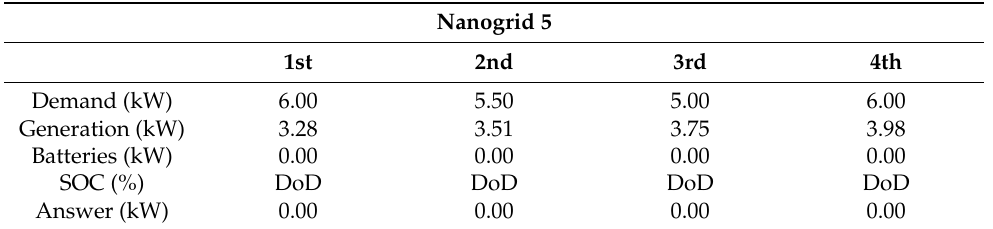
Table 6. Operation planning of HEMS5 no service is available.